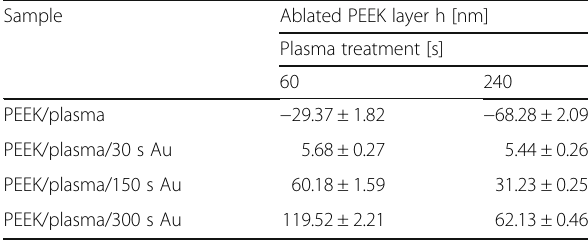
Table 1 Dependence of the thickness of an ablated polymer layer on plasma exposure time (60 and 240 s) for plasma-treated and subsequently gold-sputtered PEEK (the deposition time of 30, 150, and 300 s). The change of the PEEK/plasma sample thickness was determined in contrast to pristine PEEK, the gold-sputtered PEEK in contrast to the plasma-treated sample Sample Ablated PEEK layer h [nm] Plasma treatment [s]